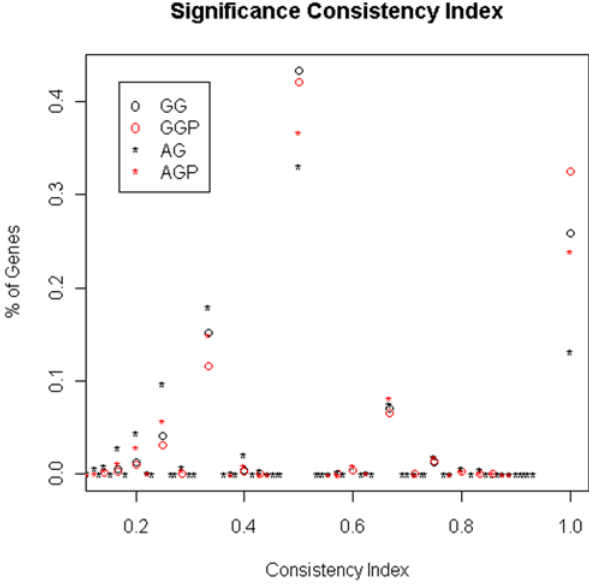
Figure 2. The distribution of genes with various significance consistency index values. A consistency index was calculated for each gene with multiple probe sets and at least one probe set significantly different across compared groups. The y-axis indicates the proportion of genes with the consistency index indicated on the x-axis. AG and GG refer to Affymetrix groupings and genome-based groupings, respectively. AGP and GGP refer to AG and GG groupings in which only probe sets called as ‘‘present’’ were included in the